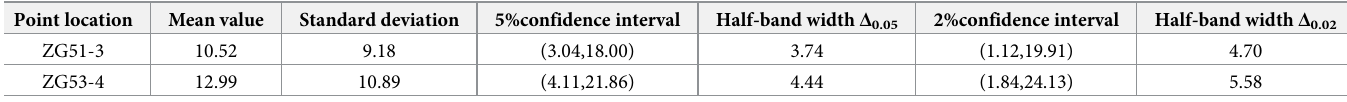
Table 7. Confidence interval calculation